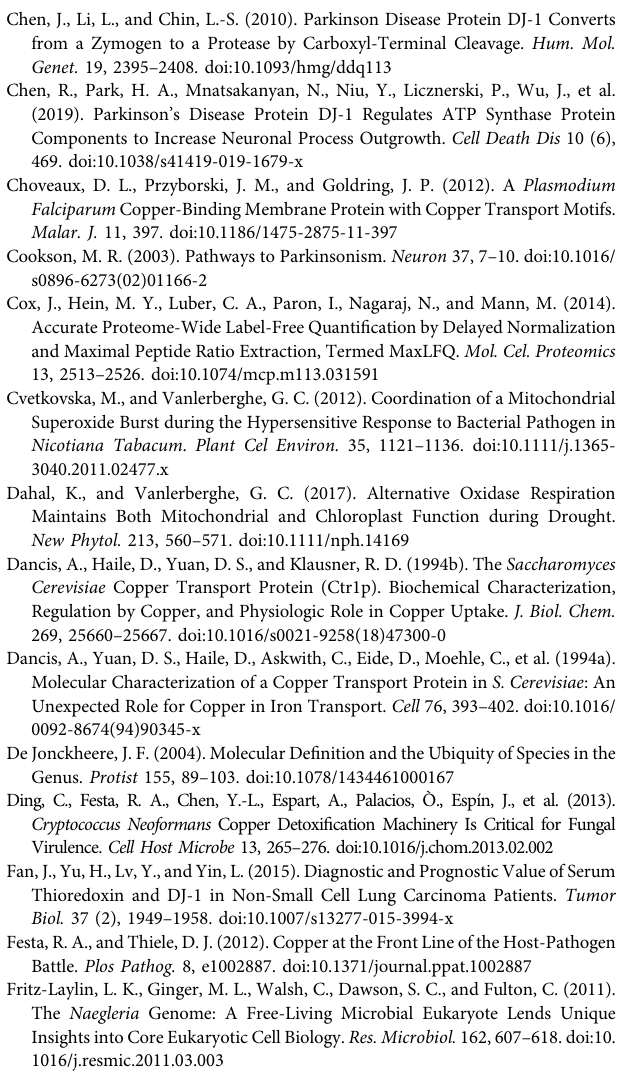
Supplementary Table 1 | List of whole-cell proteomes of both amoebas under copper-rich and copper-deprived conditions. The list is organized into thirteen sheets containing separately raw data of comparative proteomics results of N. gruberi (NG) or N. fowleri (NF) cells incubated in 25 μ M BCS (BCS) or 5 μ M neocuproine (NEO) compared to cells cultured in the presence of 25 μ M Cu2SO4 (cu), sheets containing all upregulated (UP) or downregulated (DOWN) proteins under the indicated copper-depleted conditions and the list containing summarizedtableofsigni fi cantlychangedproteinsofbothamoebasinbothcopper- deprived conditions. Upregulated and downregulated proteins were selected and fi ltered based on the criteria listed in the Methods